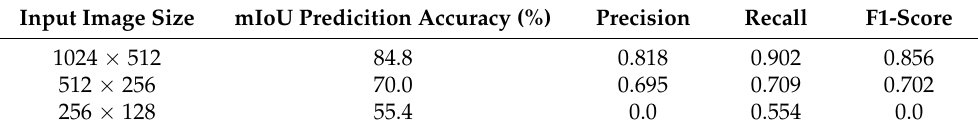
Table 7. Failure detection result for the selected network